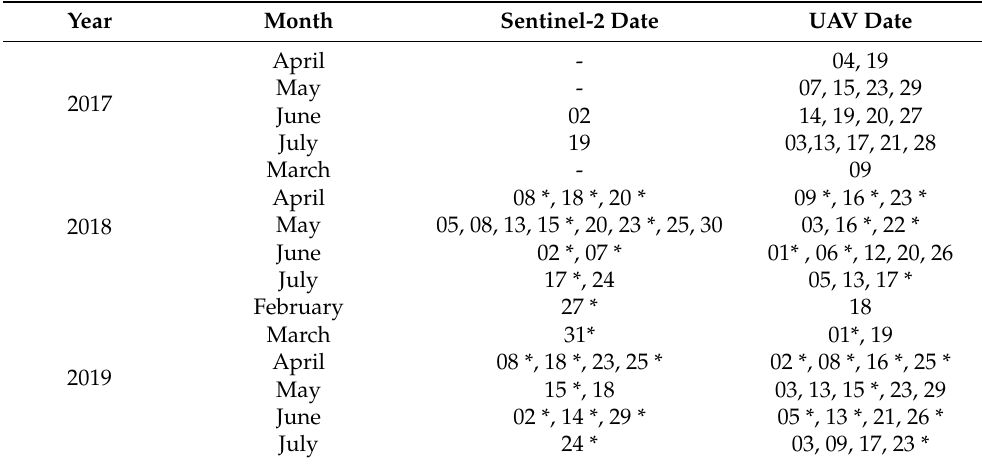
Table A3. Sentinel-2 and UAV data acquisition dates of the trial sites. Dates of the same month and year are opposed to emphasize the achieved temporal resolution of both remote sensing